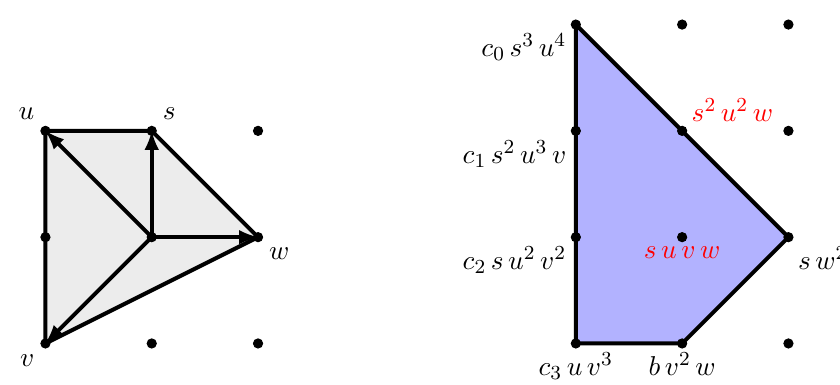
Figure 1 . On the left : the toric polygon, referred to as F 6 in [28], of the (cid:12)ber ambient space Bl 1 P 112 of the blown-up U(1) model (1.13). On the right : the dual polygon, giving rise to the resolved hypersurface equation (3.1). As pointed out in [16], by assuming a unit coe(cid:14)cient in front of the term s w 2 , the two red monomials can be absorbed by a shift of w by a multiple of u . the Weierstrass model (2.15). Crepant resolutions in F-theory [52{57] allow one to